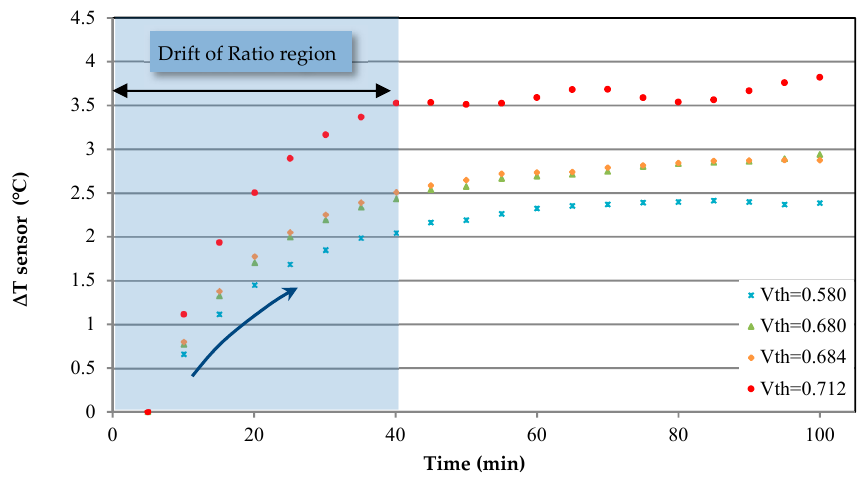
Figure 7. Temperature changes of sensor within 100 min.